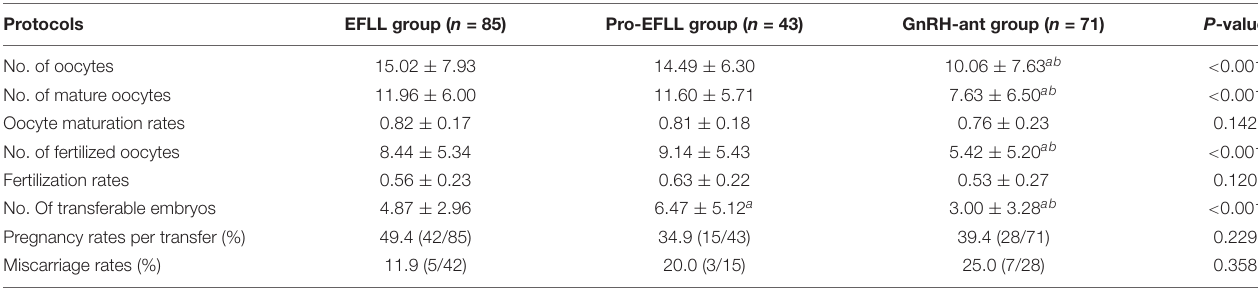
TABLE 3 | Comparison of clinical outcomes between the three